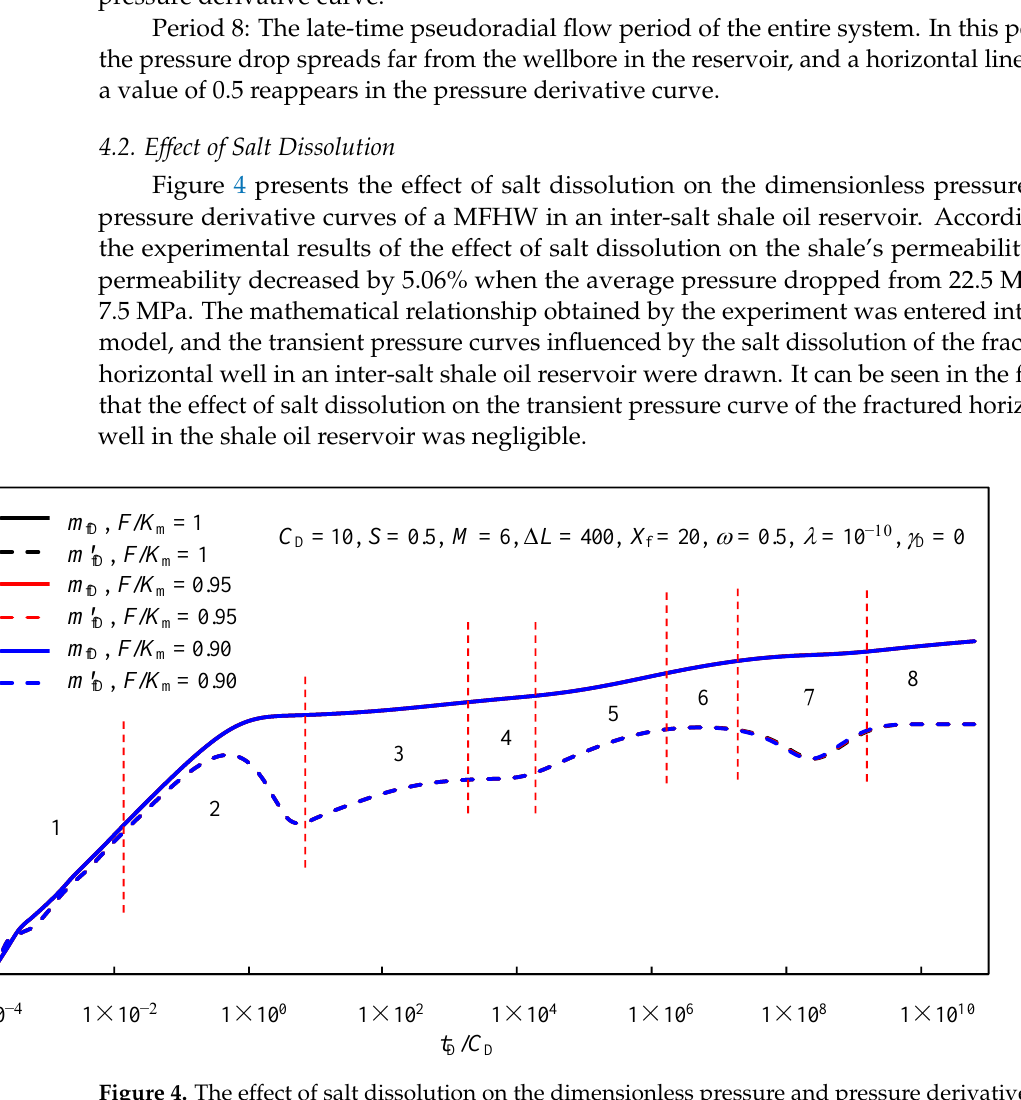
Figure 3. Bilogarithmic type curve of the dimensionless pressure and the pressure derivatives of a MFHW in an inter-salt shale oil reservoir.